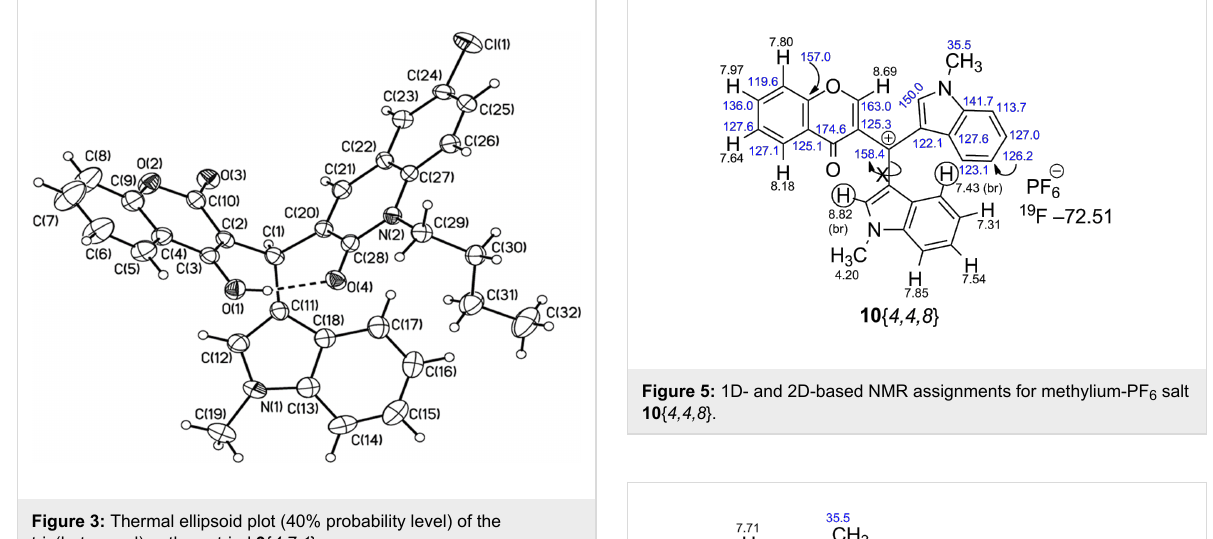
Figure 3: Thermal ellipsoid plot (40% probability level) of the tris(heteroaryl)methane triad 9 { 4,7,1 }.